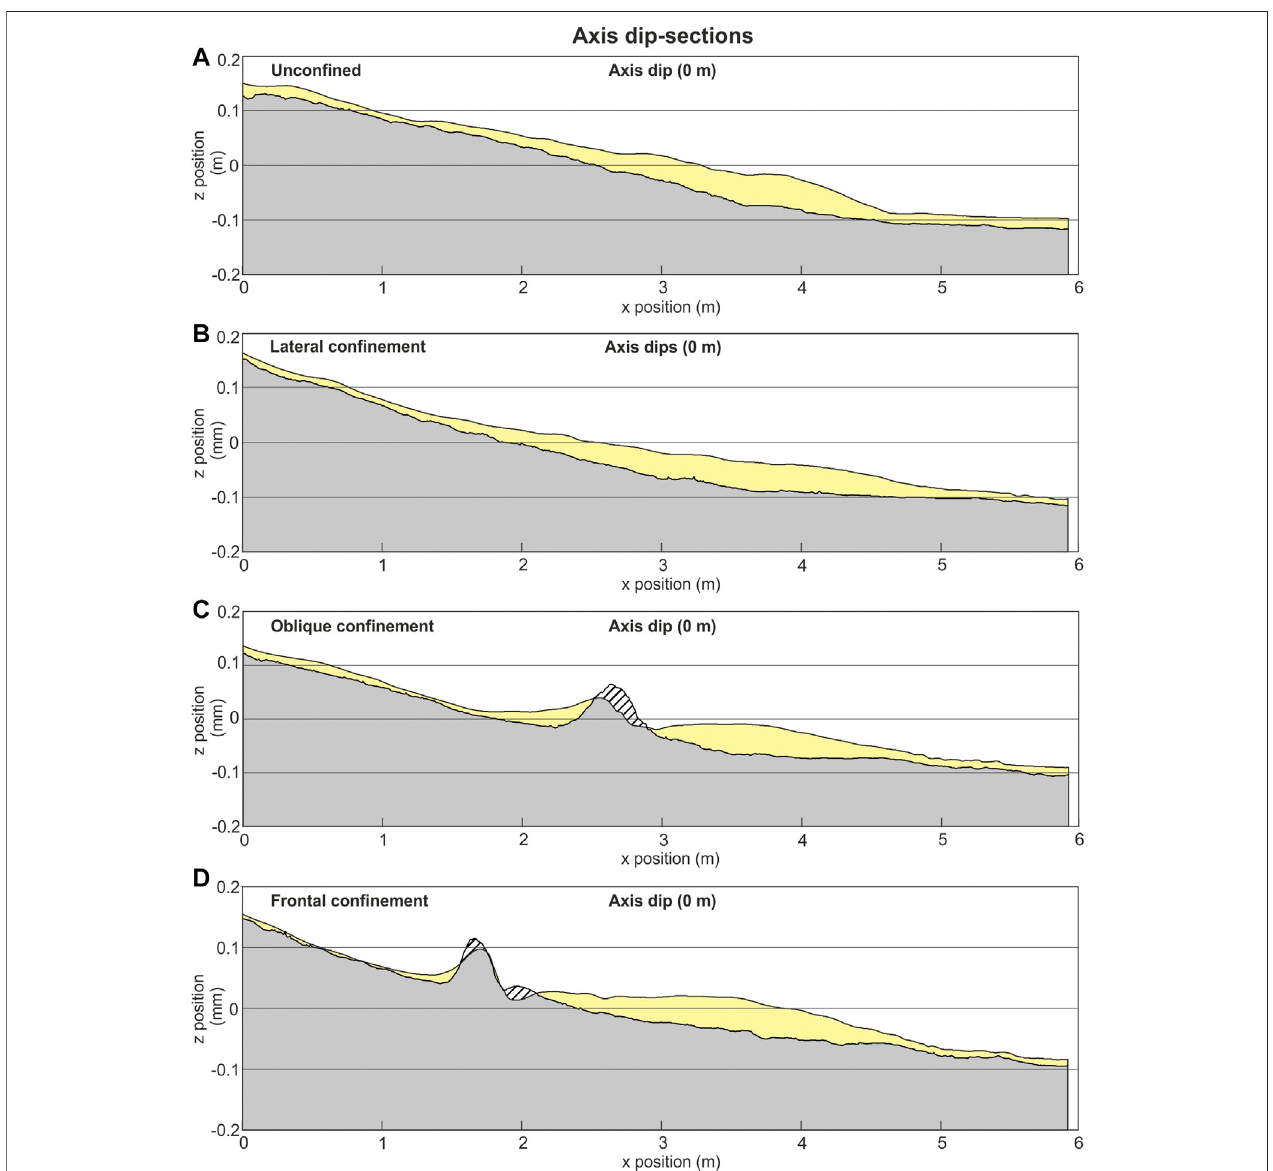
FIGURE 6 | Dip sections along the axis of the deposits. Section locations on Figure 3 . Striped pattern indicates erosion.